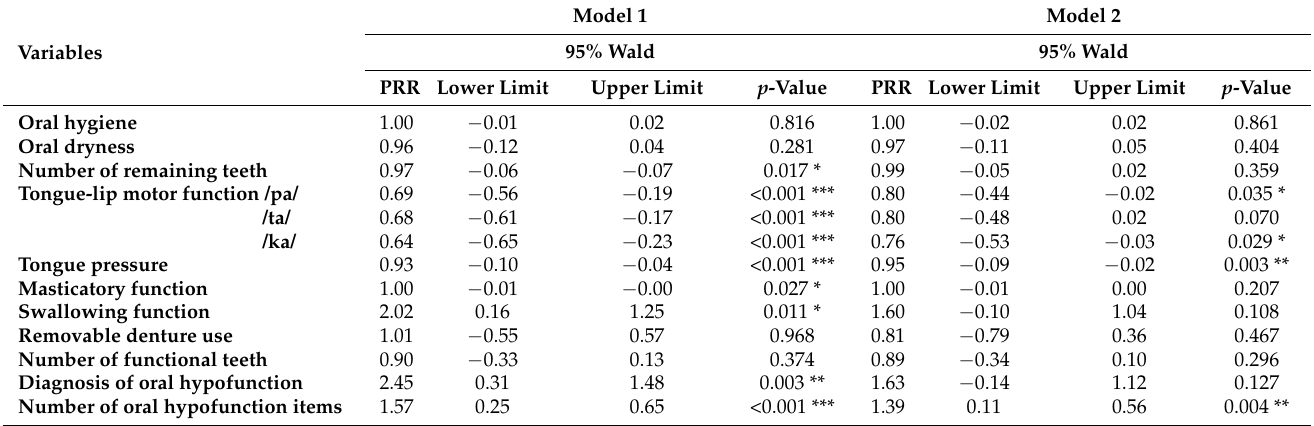
Model 1. Poisson logistic regression analysis was performed. Dependent variable: two sarcopenia groups. Independent variables: each item of the oral function assessment and the number of functional teeth,